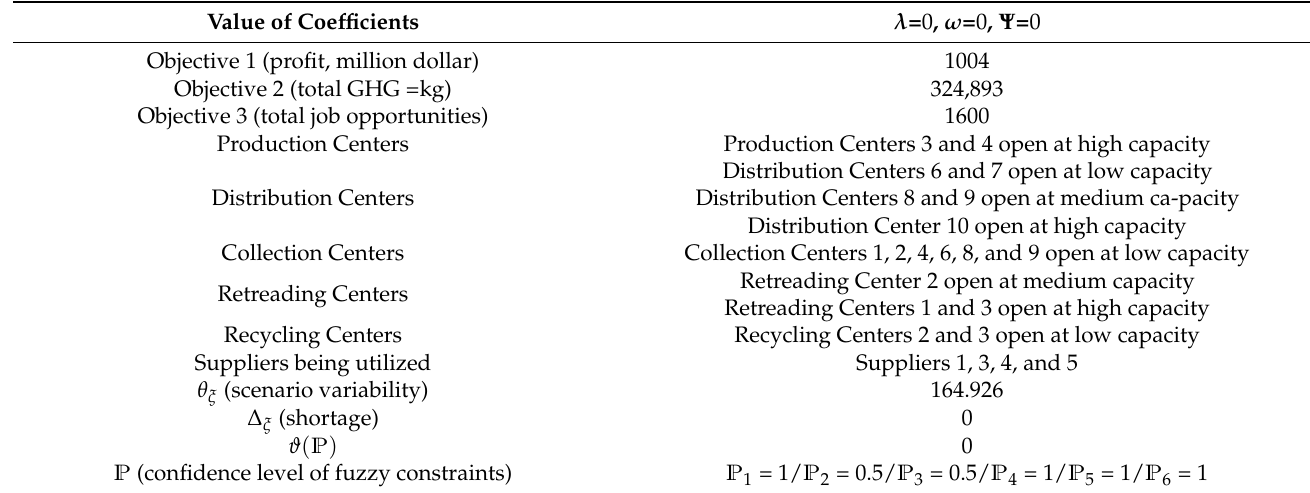
Figure 7. Optimum network configuration and product flow. Table 7. Summary of optimum results, using mean